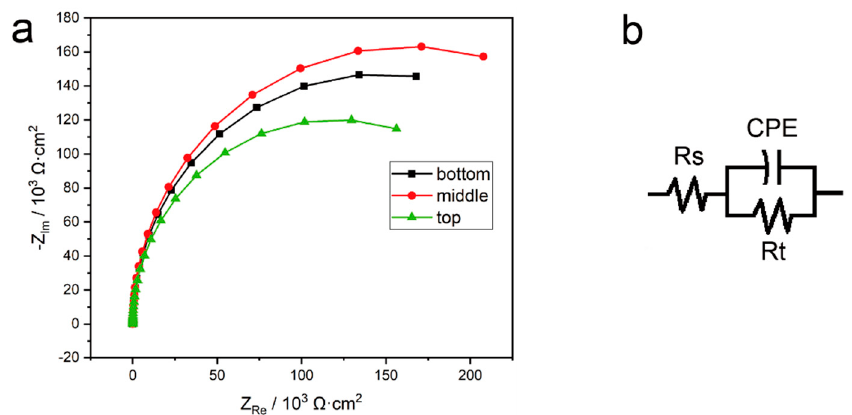
Figure 17. Electrochemical impedance test data of the bottom, middle, and top region specimens of the wire arc additive manufacturing (WAAM) 316L as-deposited sample: ( a ) Nyquist plots and ( b ) equivalent circuit model (EEC).